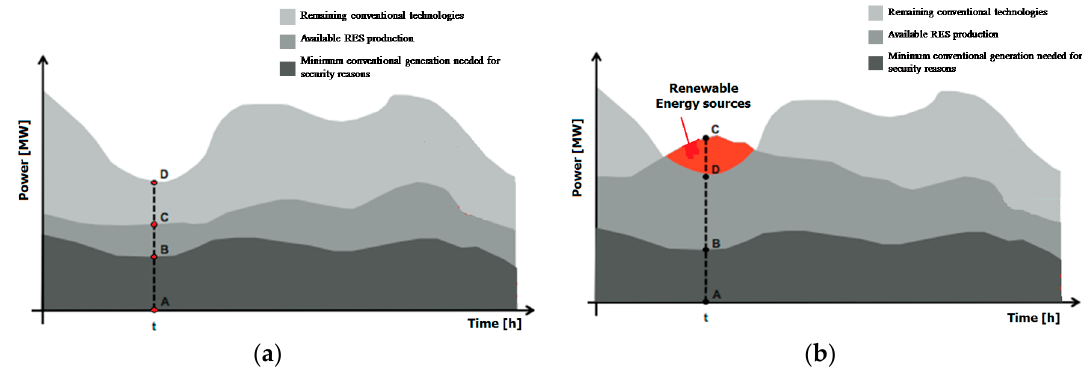
Figure 1. ( a ) Load profile and generation distribution in case of “normal” operation; ( b ) Load profile and generation distribution with RES curtailment requirements [28].